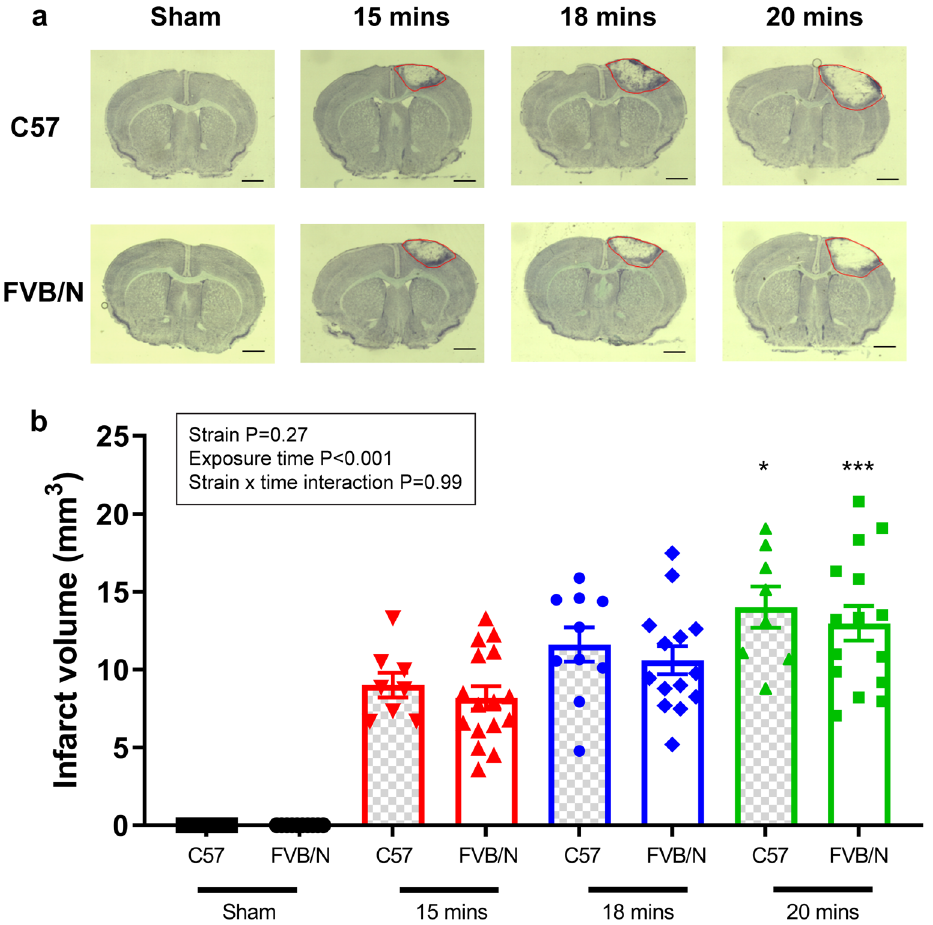
Figure 1. ( a ) Representative images of thionin stained coronal brain sections and infarct volumes mm 3 ( b ) from either sham operated non-stroked animals (C57Bl/6 n = 11, FVB/N n = 10), or animals with light exposures of 15 min (C57Bl/6 n = 8, FVB/N n = 16), 18 min (C57Bl/6 n = 10, FVB/N n = 14), and 20 min (C57Bl/6 n = 8, FVB/N n = 15) during stroke induction. Infarct area signified with a red line. Data are presented as mean ± SEM; *P < 0.05, ***P < 0.001 vs 15 min in respective group, two-way ANOVA followed by Tukey’s multiple comparisons test. Scale bar represents 1